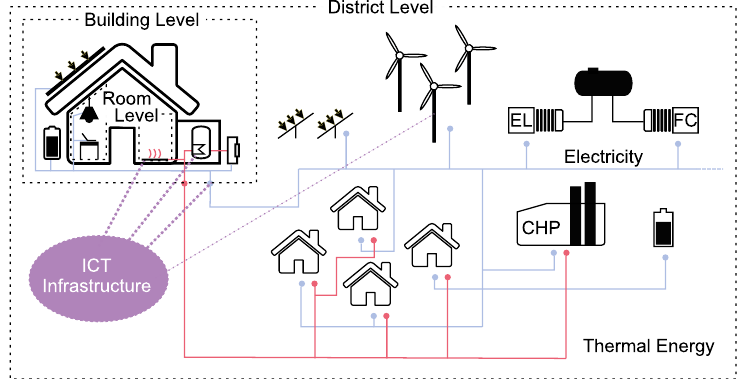
Figure 1. Visualization of the physical inter-connections on the district level, the sensor and control networks on the room level (e.g., floor heating and lighting, left), building-wide metering (e.g., heating and electricity), and existing building automation (e.g., heating and air-conditioning); connection of BACS components to an overarching ICT architecture (dotted